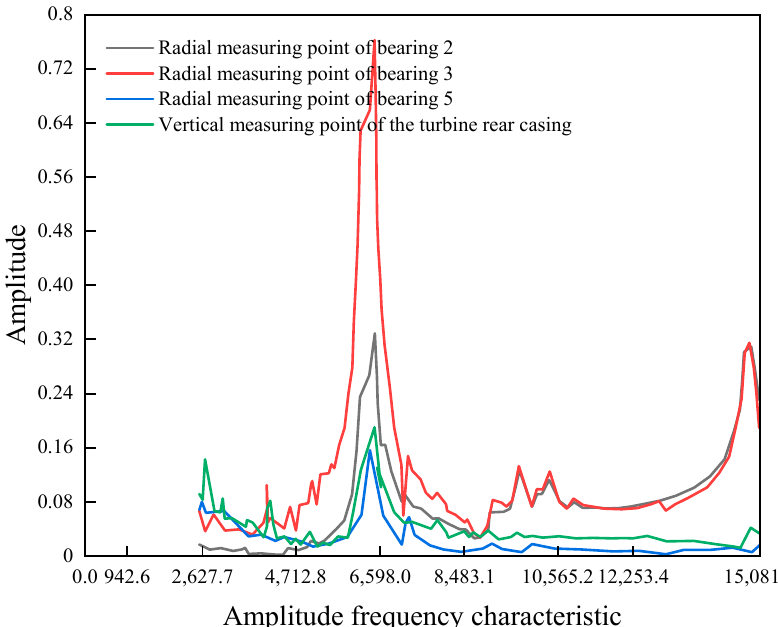
Figure 6. Time response and frequency spectral for vibration acceleration signals on the casing. Figure 7 shows the vibration acceleration transmission amplitude’s value of the measuring point of the casing. The rotating force exciter is located at bearing No. 5. The purple line is the curve of the radial measuring point of bearing 2, the brown line is the curve of the radial measuring point of bearing 3, the yellow line is the curve of the radial measuring point of bearing 5, and the green line is the of the vertical measuring point of the turbine rear casing.